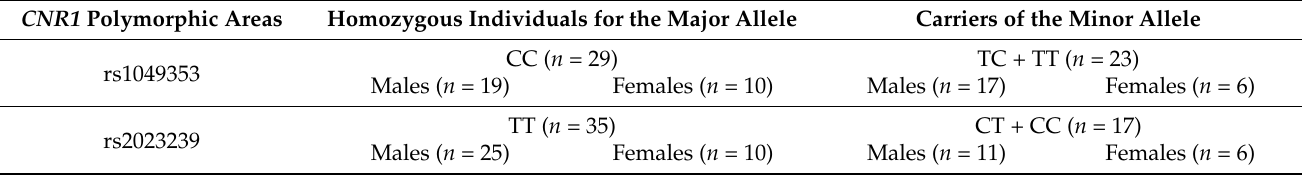
Table 2. Genotyping results and numerical representation of group size and composition following subject grouping by genotype at the CNR1 rs1049353 and rs2023239